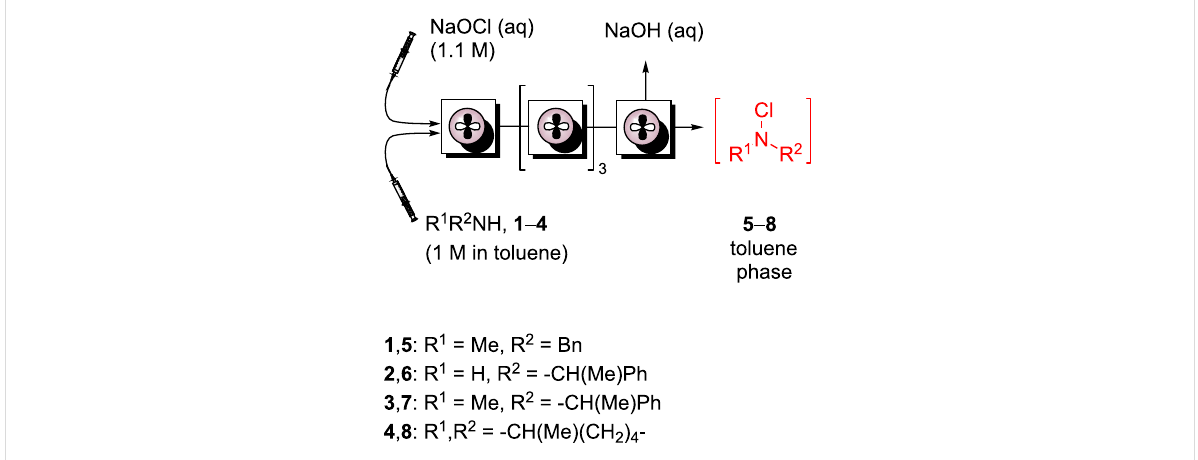
Table 1: Continuous N -chloramine